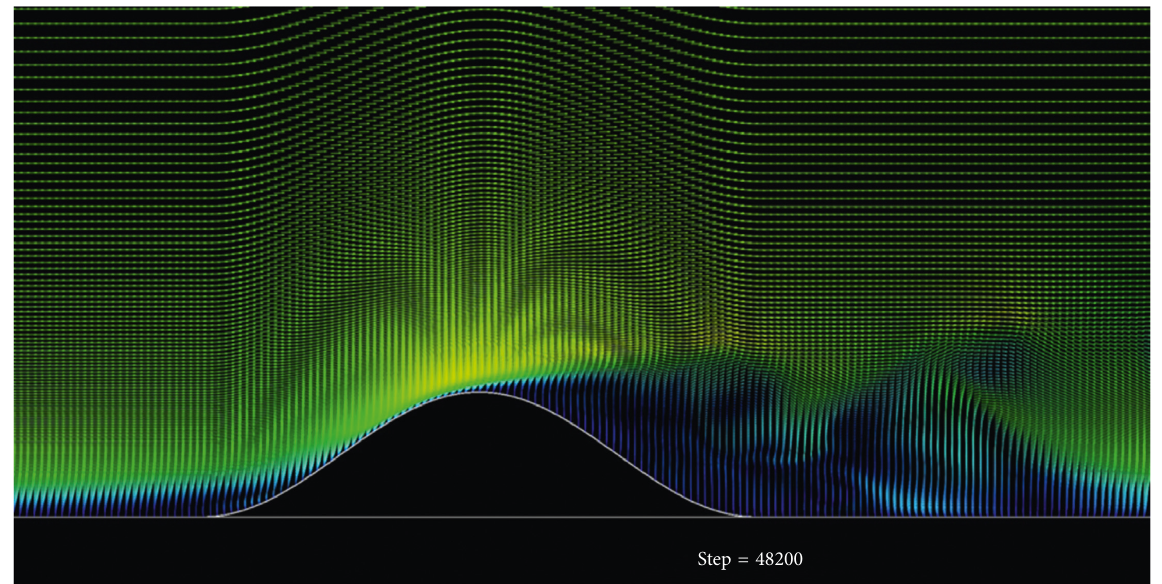
Figure 12: Computed vector field at the center line of the isolated peak example (Figure 1). The size of the mesh system was set to 801 × 181 × 181, and the Reynolds number based on the height of the peak was 10 4